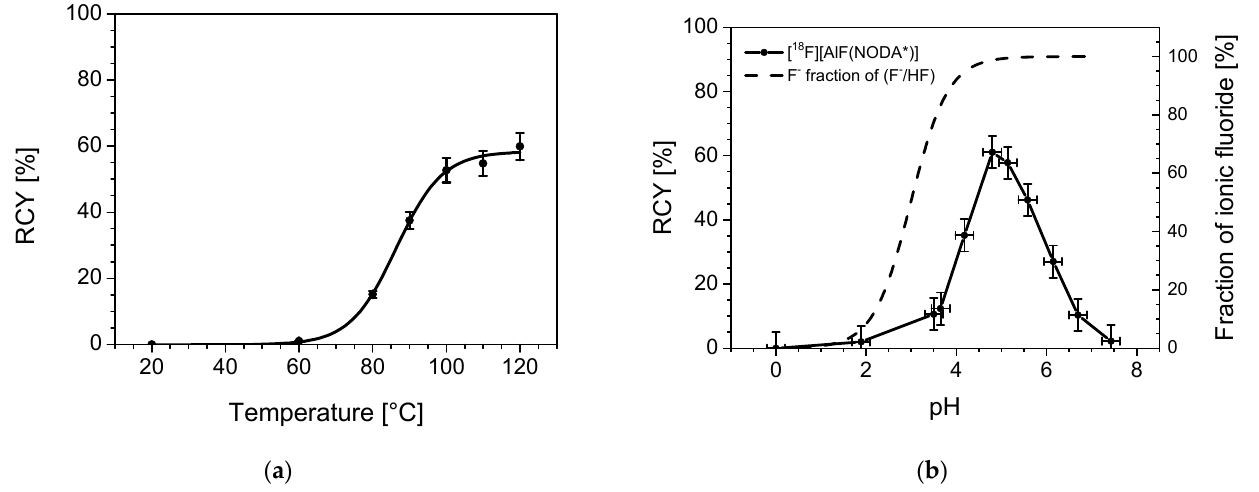
Figure 5. ( a ) Temperature dependency of 18 F labelling of [Al(OH)(NODA*)]. Reaction parameters: 0.2 mM [Al(OH)(NODA*)], 0.15 M NH 4 OAc buffer pH of 4.5, total volume of 100 µL with water/ethanol = 50:50, 20-min reaction time. ( b ) Influence of the pH on [ 18 F]fluoride coordination to [Al(OH)(NODA*)]. Reaction parameters: 0.2 mM [Al(OH)(NODA*)], 0.15 M of NH 4 OAc-buffer, pH of <3 by addition of HCl, 105 °C, total volume of 100 µL, solvent: water/ ethanol = 50:50, 20-min reaction time. Shown also in the graph is the corresponding fraction of ionic fluoride among the two species HF and fluoride. This function is calculated based on pKa = 3.2